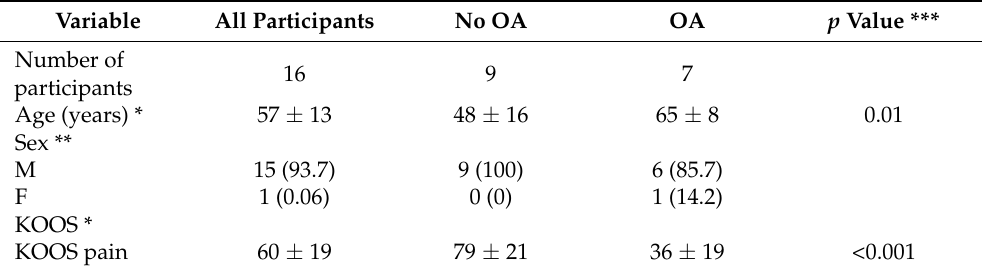
Table 1. Participants’ demographics, KOOS score, and visual analog pain